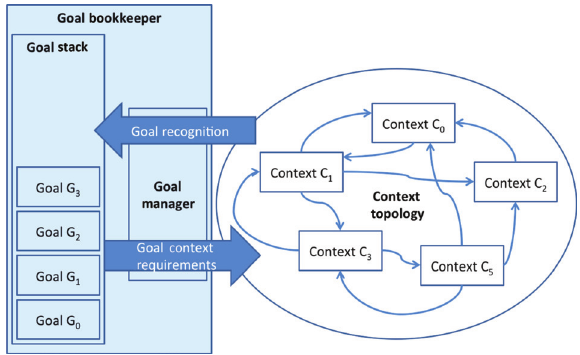
Figure 28. Goal Management Block